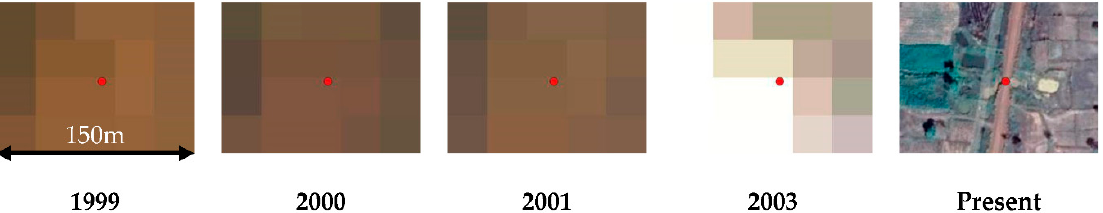
Figure 31. Satellite images of the Takoy 1 bridge, from which the year of construction cannot be judged.